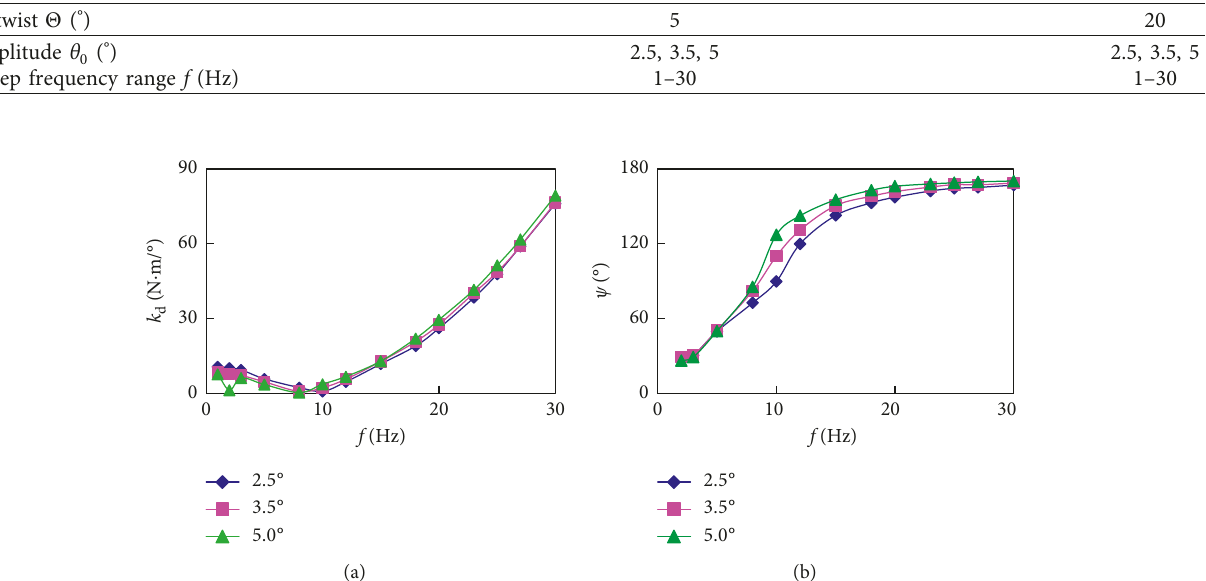
d . (b) Lag angle error ψ .